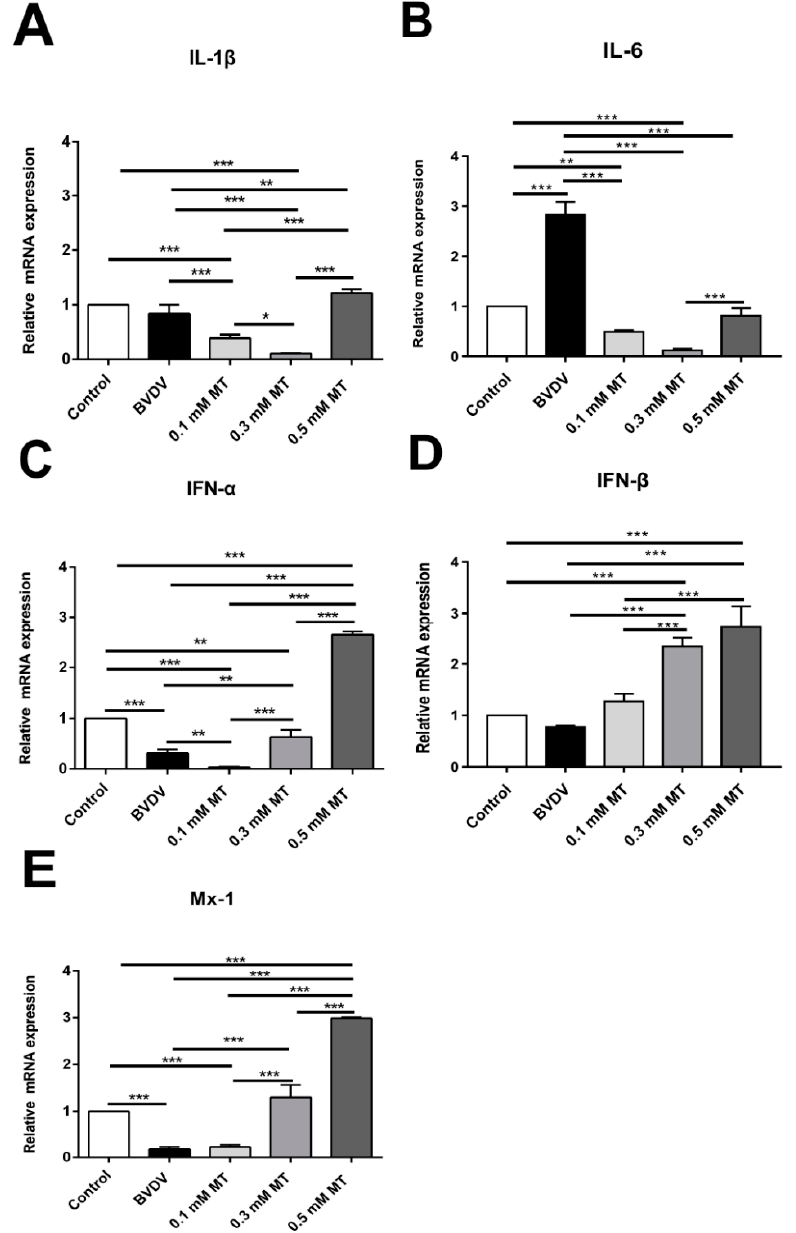
Figure 2. The effect of melatonin on the expressions of cytokines in MDBK cells. MDBK cells were inoculated with BVDV (MOI = 5) in the presence or absence of MT. Total RNA was extracted from cell lysates at 36 h post-infection. The relative expression of ( A ) IL-6 mRNA; ( B ) IL-1 β mRNA; ( C ) IFN- α mRNA; ( D ) IFN- β mRNA; ( E ) Mx 1 mRNA was assessed by RT-qPCR. The values in each column represent the mean ± SEM of three individual experiments detected in triplicate. * p < 0.05; ** p < 0.01; *** p <